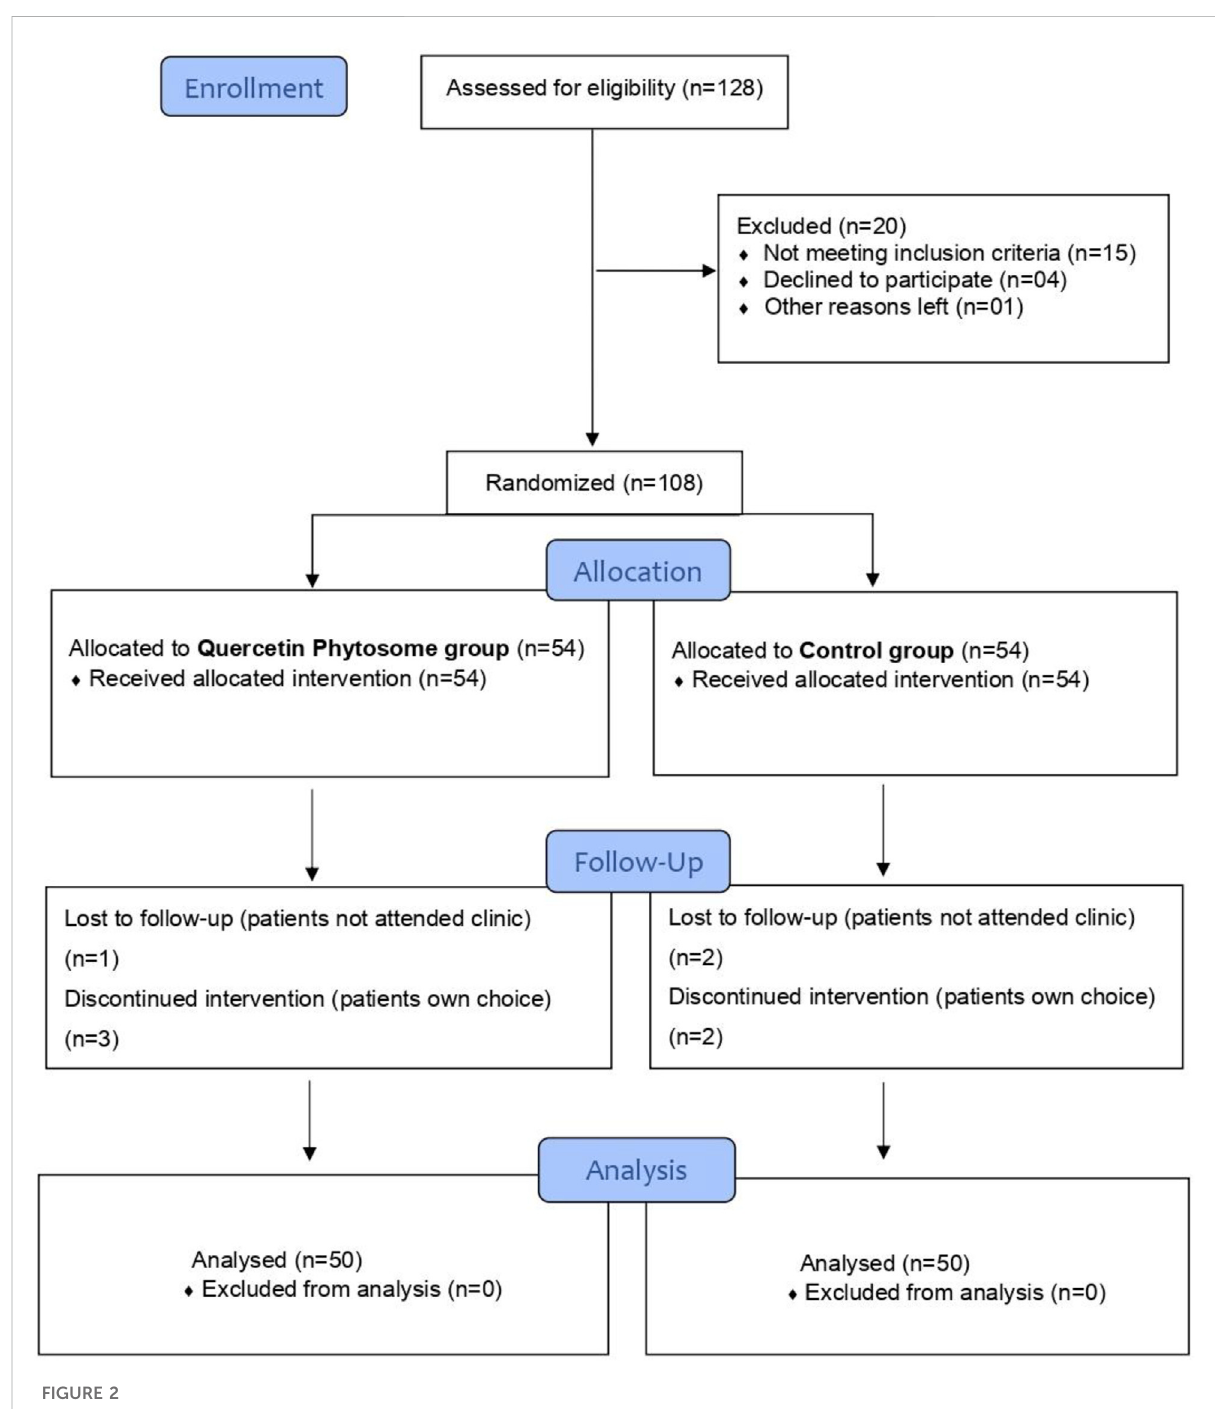
FIGURE 2 Study CONSORT fl